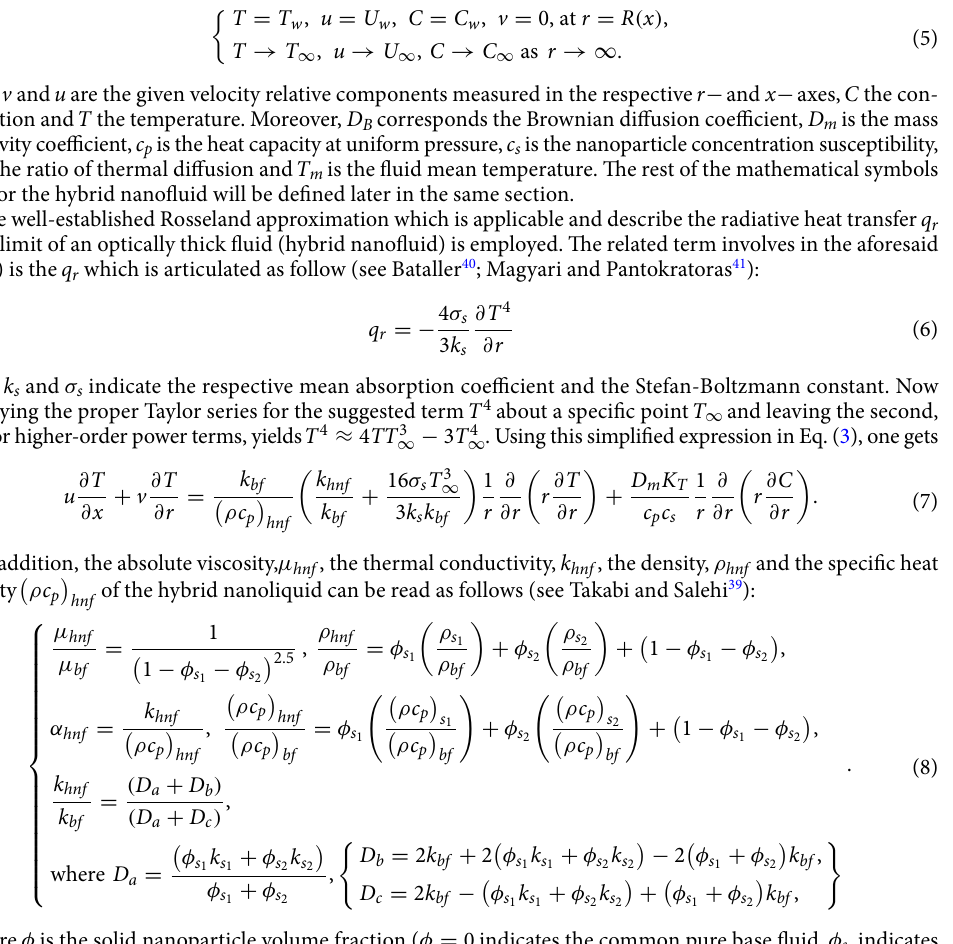
k s 2 respectively represent the thermal conductivities of the common base fluid and the two distinct hybridized alloy nanomaterials, µ bf , µ s 1 and µ s 2 are absolute viscosities of the common base liquid and the two distinct hybridized alloy nanomaterials, respectively. The characteristics of the physical data are shown in Table 1 for the two dissimilar nanoparticles AA7072 and AA7075 along with the common base fluid, water. Now, the following self-similarity variables (see Khan et al. 36 ) are considered: